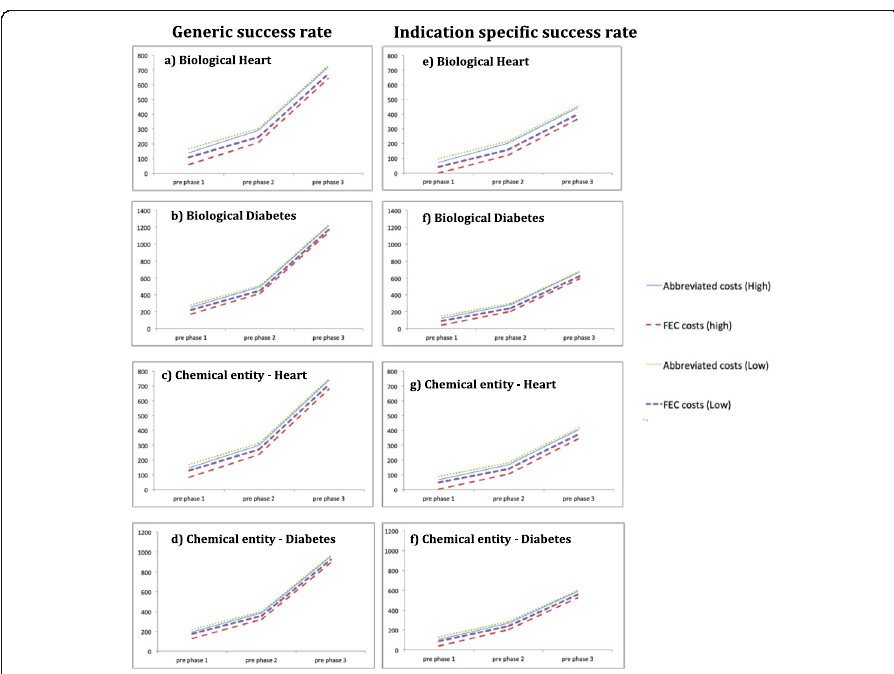
Fig. 1 Stage-specific rNPV calculations for the four modelled interventions, using generic success rates comparing abbreviated or full high and low costs, and indication-specific success rates comparing abbreviated or full high and low costs . rNPV calculations were made for chemical entity or biological interventions for diabetic or heart disorders using low and high versions of abbreviated or full economic costs and generic success rates (panels a , b , c , and d ) and for the latest indication-specific success rates (panels e , f , g , and h